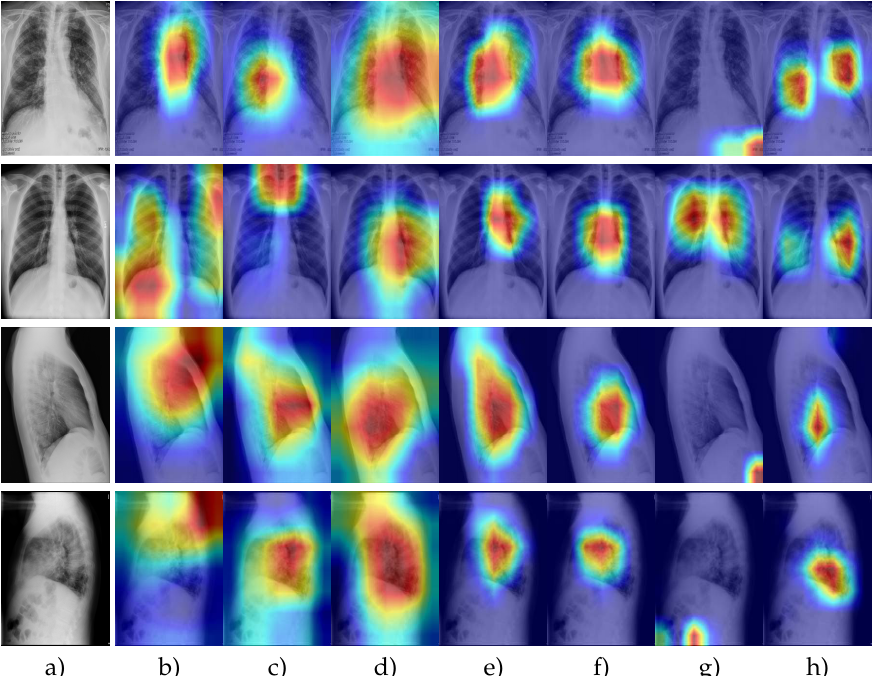
Figure 13. Samples from the COVIDx dataset to show the feature attention. All input images contain COVID-19 cases. The sequence shown in the figure is ( a ) input images, ( b ) ResNet, ( c ) DenseNet, ( d ) GoogleNet, ( e ) ResNeXt, ( f ) MNASNet, ( g ) EfficientNet, and ( h )